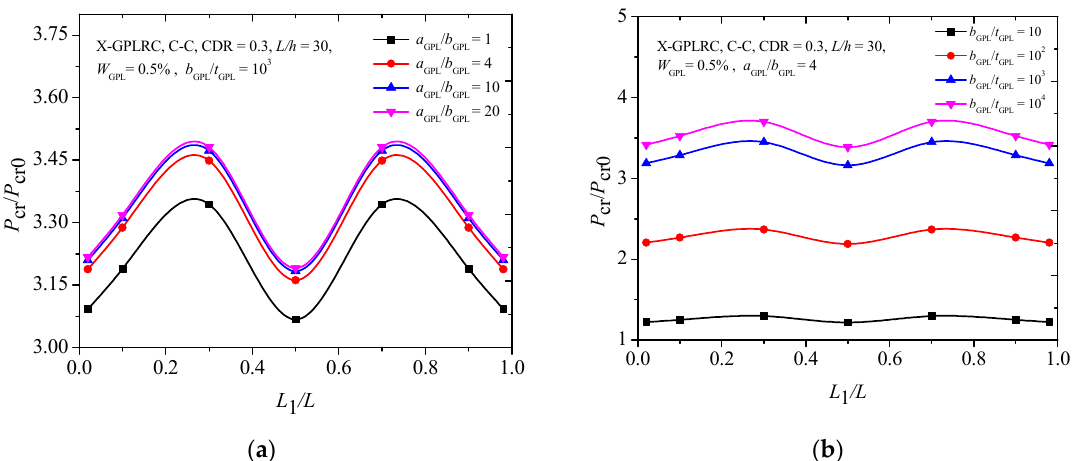
Figure 10. E ff ects of ( a ) aspect ratio and ( b ) width-to-thickness ratio on the critical buckling load of cracked FG-X-GPLRC beam.